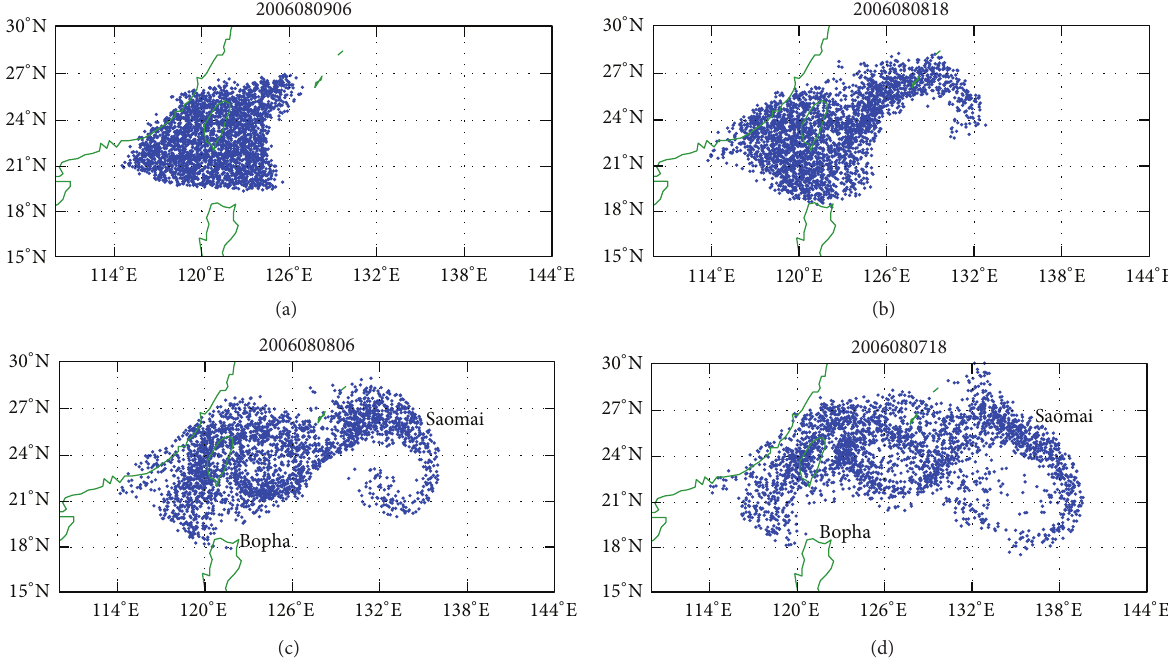
Figure 11: Back trajectories of the cluster of moisture particles released at 1200 UTC 9 August in Bopha (115.5 ∼ 125.5 ∘ E, 20.1 ∼ 25.0 ∘ N) in the FLEXPART model at (a) 0600 UTC 09 August, 2006, (b) 1800 UTC 08 August, (c) 0600 UTC 08 August, and (d) 1800 UTC 07 August. observations. This problem is beyond the discussion in